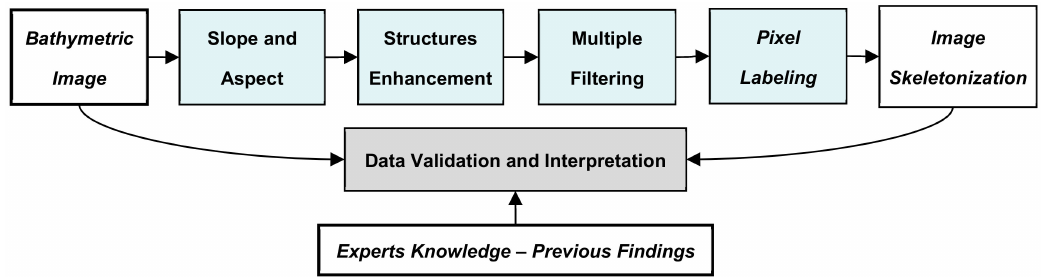
Figure 2. Flow-chart illustrating the methodology of the present